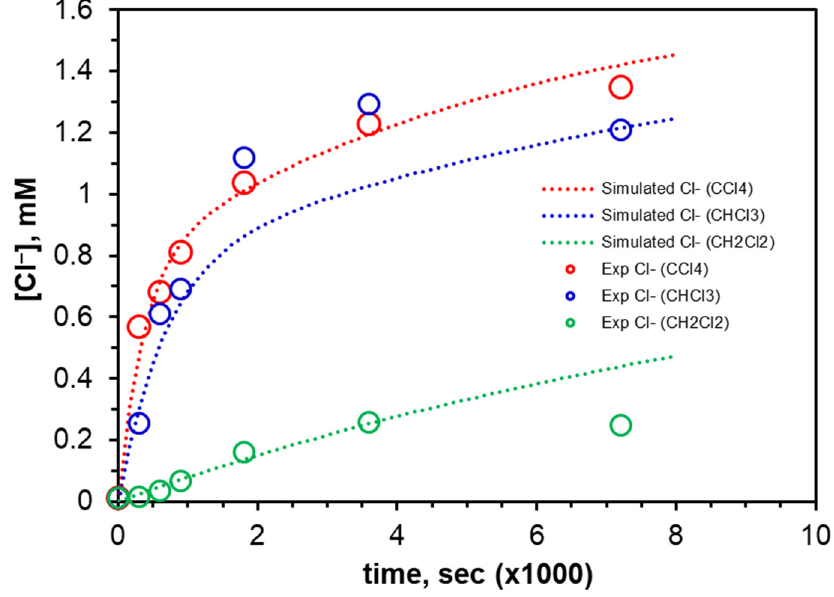
Figure 5. Concentration variation on measured chloride ions from the dechlorination rate of CCl 4 (red), CHCl 3 (blue), and CH 2 Cl 2 (green) for each of the 0.825 mM concentrations of the organochlo- rides after electrolysis.